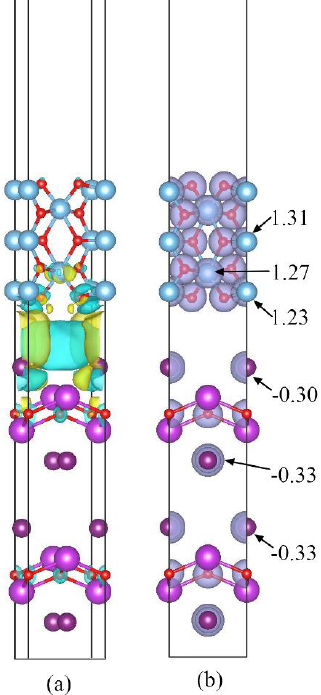
Figure 6. ( a ) 3D charge density difference for the 1I-BiOI/TiO 2 heterojunction with an isovalue of 0.01 e/Å 3 . Yellow and cyan isosurfaces represent charge accumulation and depletion in the space respectively. ( b ) Mulliken population charge distribution maps of 1I-BiOI / TiO 2 heterojunction.